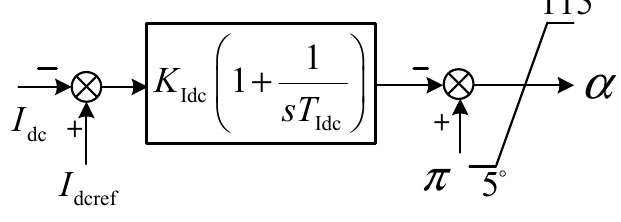
Figure 4. Constant direct current controller of LCC.